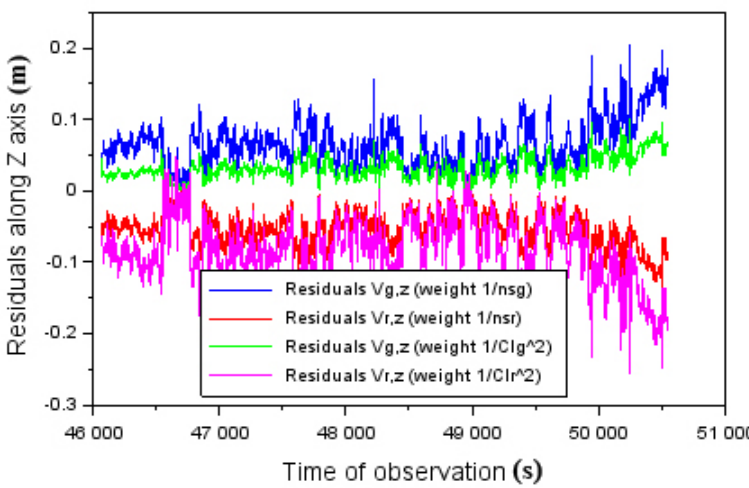
Figure 7. Residuals